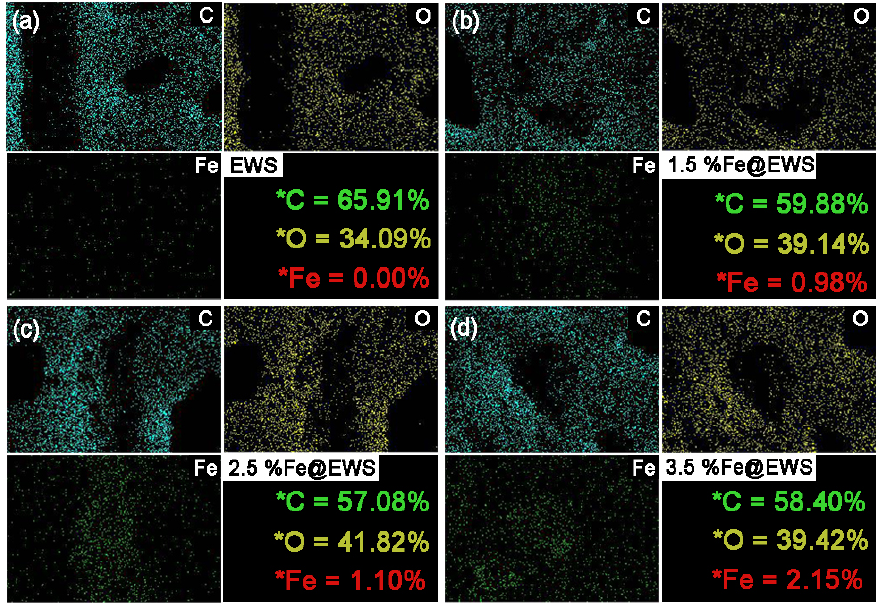
Figure 2. EDX images of Control samples (EWS) ( a ), 1.5%Fe@EWS ( b ), 2.5%Fe@EWS ( c ), and